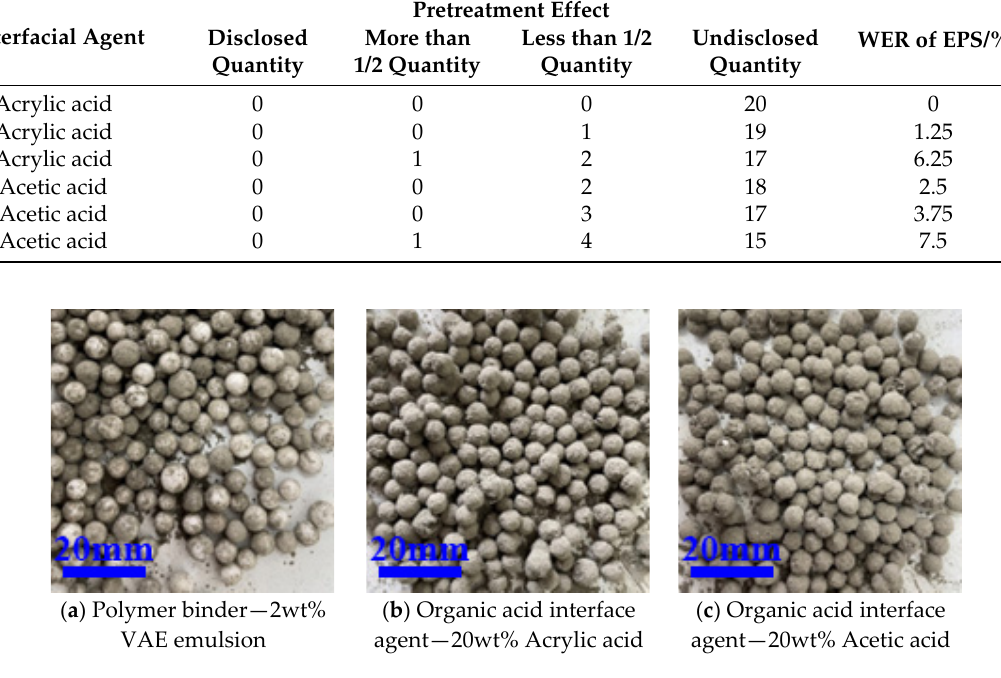
Figure 5. The exposure of CSLA after 1.5 m height falling.